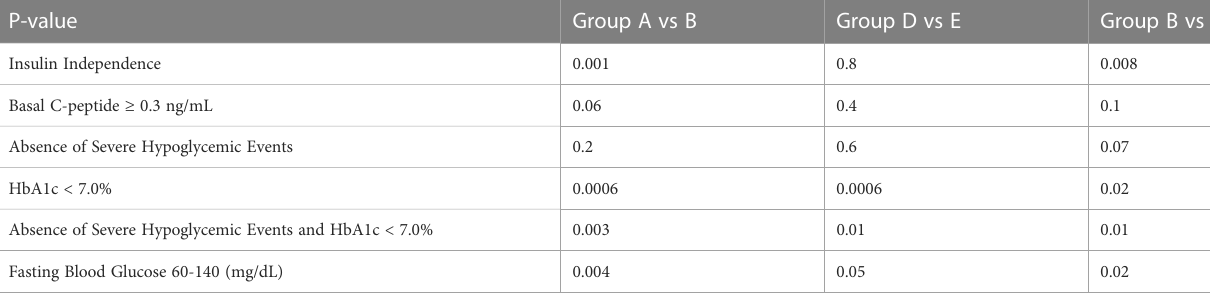
TABLE 4 Best predictors by p-value for ITA ’ s with follow-up data at least 1 year.